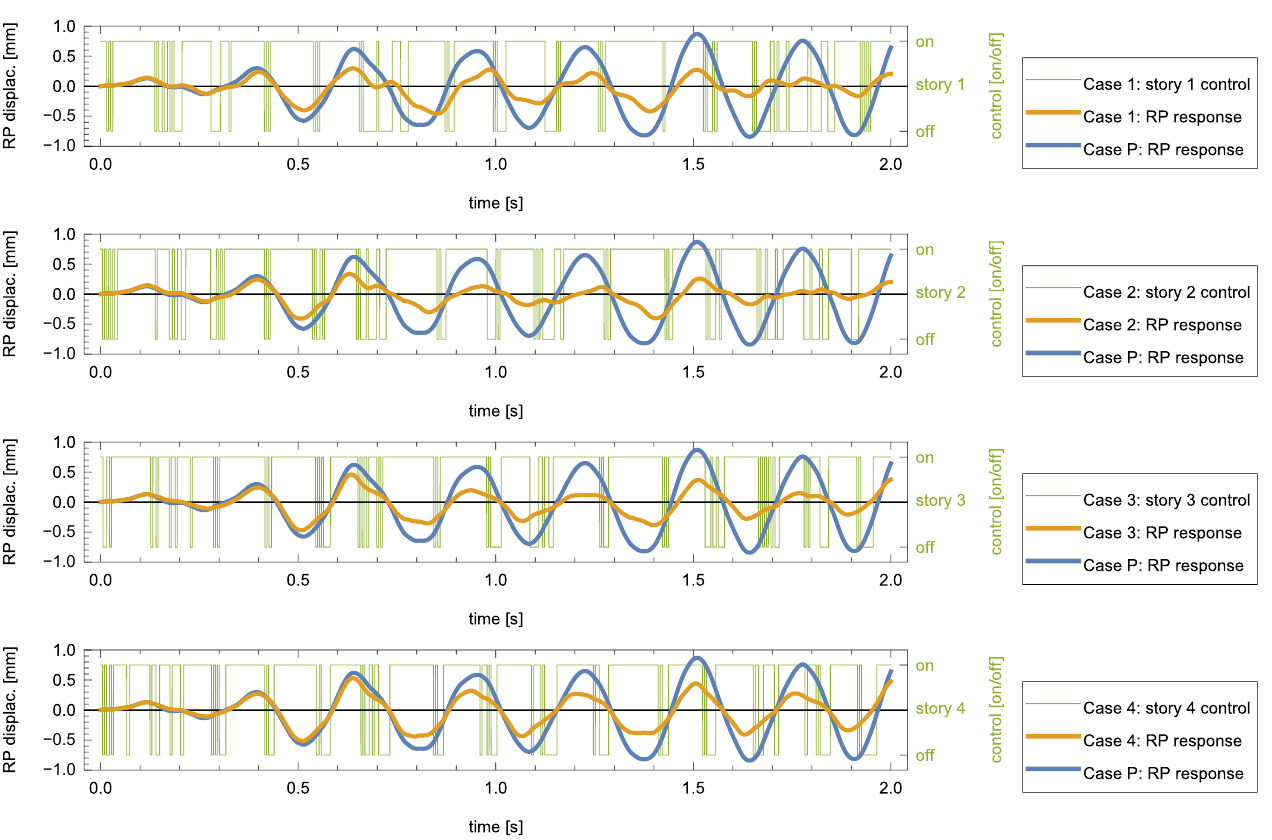
Figure 4. Control functions of the four stories for the fully controlled structure together with the corresponding RP displacement (Case A) and the reference RP displacement in the passive structure (Case P).